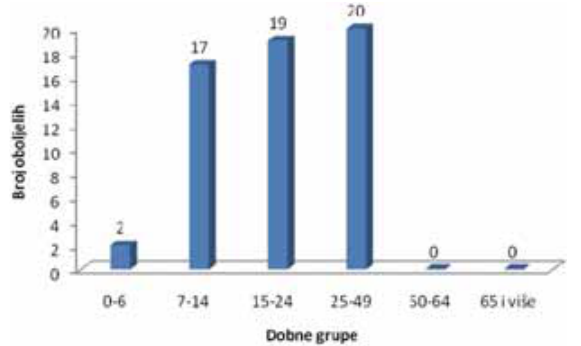
SLIKA 5. Distribucija oboljelih od VHA po dobnim